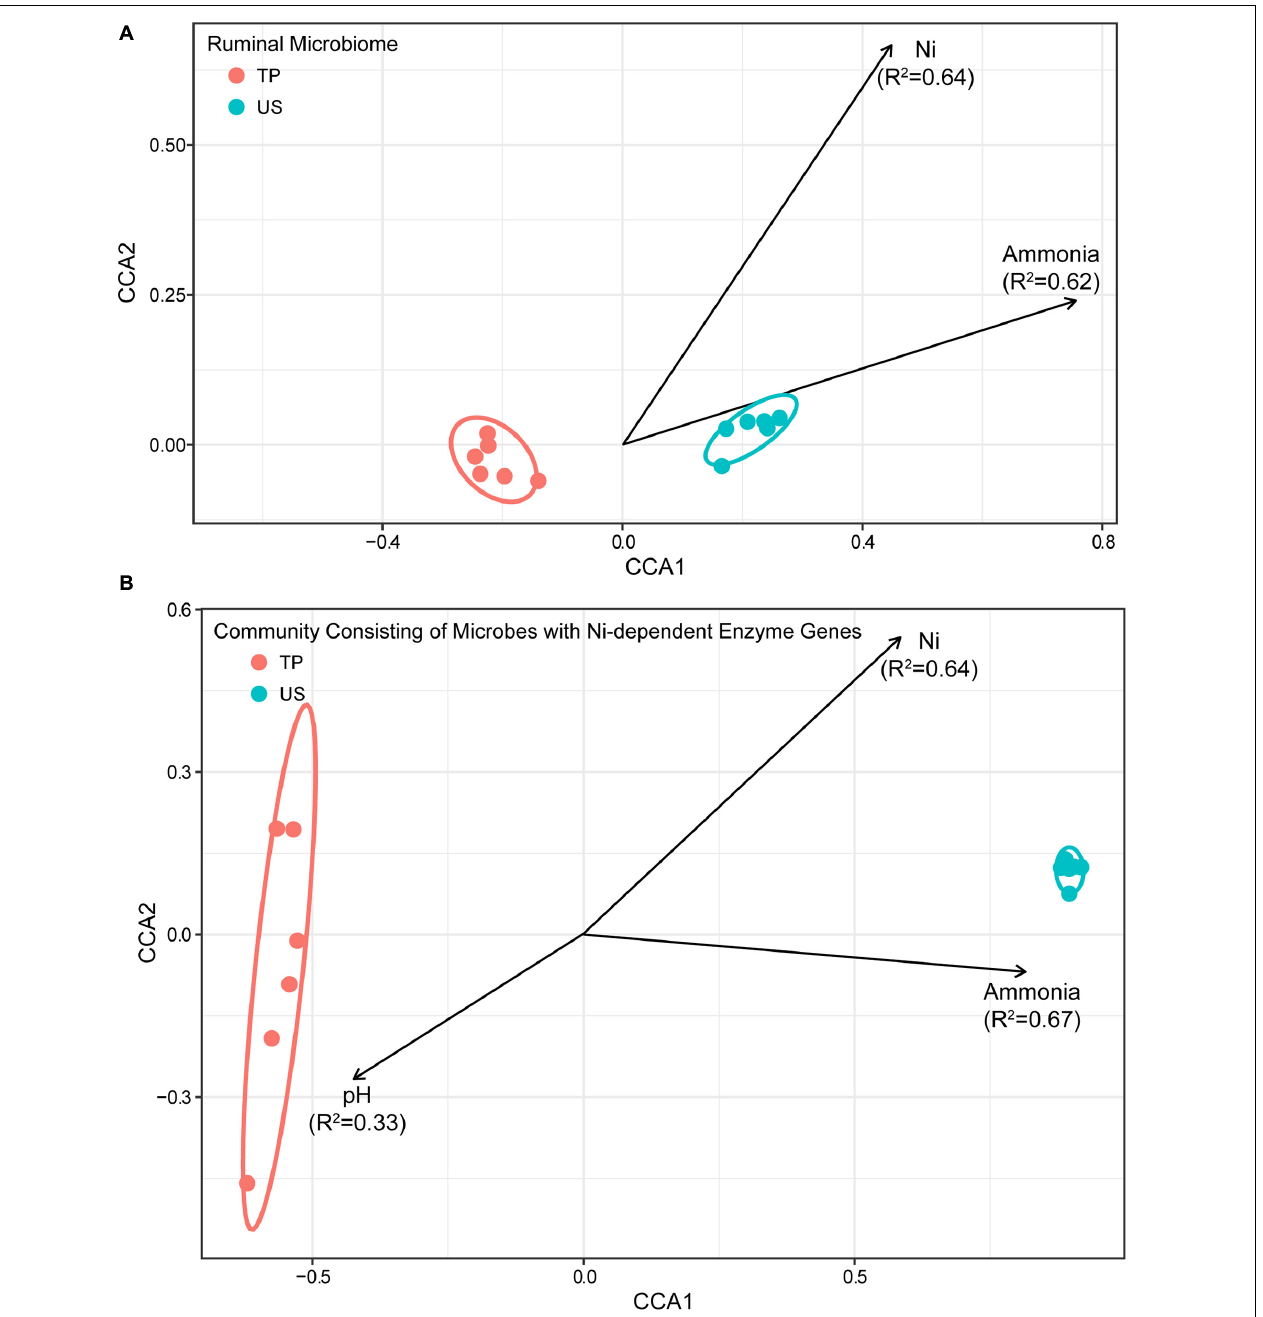
FIGURE 2 | Constrained correspondence analysis plot depicting the relationship between rumen pH, Ni, and ammonia concentrations (environmental variables), and the structure of (A) the ruminal microbiome and (B) the community of microbes with Ni-dependent enzyme genes. Arrows represent the environmental variables that showed significant correspondence (FDR < 0.05) to the structure of the ruminal microbiome or community of microbes with Ni-dependent enzyme genes. Each point represents one rumen fluid sample. Arrow direction indicates the correspondence direction and arrow length indicates the importance/strength of the correspondence between the variable and the community